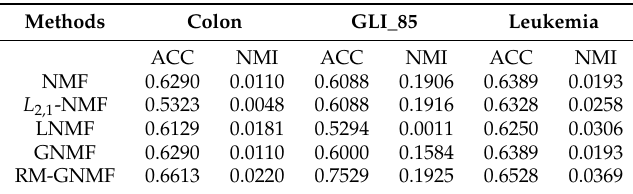
Table 2. Clustering results on different datasets. NMF: non-negative matrix factorization; GNMF: graph regularized non-negative matrices factorization; RM-GNMF: robust manifold non-negative matrix factorization; NMI: normalized mutual information.